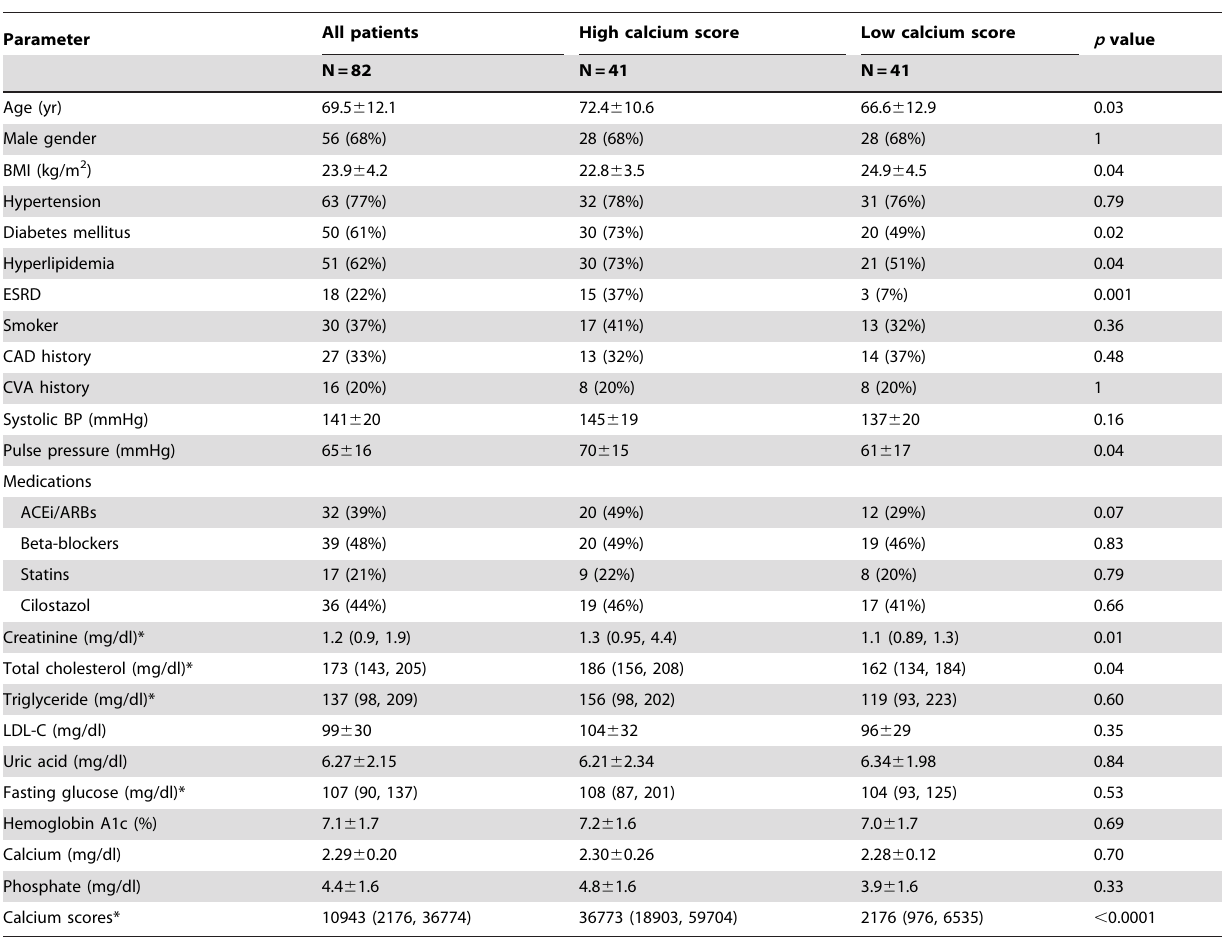
Table 1. Baseline characteristics of study